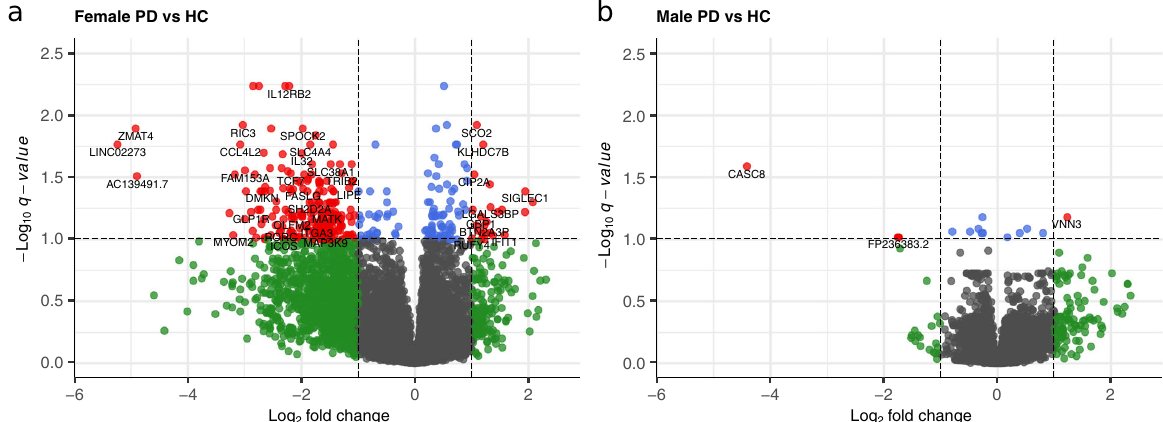
Fig. 3 More genes were differentially expressed between PD and HC in females than males. Differential expression of genes between Parkinson disease (PD) and healthy control (HC) subjects were visualized with volcano plots in females ( a ) and males ( b ). A q -value threshold of 0.1 and a fold-change (FC) threshold of 2 (log2 FC of 1) was applied to visualization. Each individual dot represents a single gene; black dots represent genes with a non-signi fi cant q -value and |log2 FC | < 1, green dots represent genes with a non-signi fi cant q -value and |log2 FC | > 1, blue dots represent genes with a signi fi cant q -value and |log2 FC | < 1, and red dots represent genes with a signi fi cant q -value and |log2 FC | > 1. Select genes are labeled in each plot. Note that while CCL4 is both signi fi cant and has a large fold change ( q -value < 0.0001, FC = − 3.7) in the females, it is located outside the plotting region of the female volcano